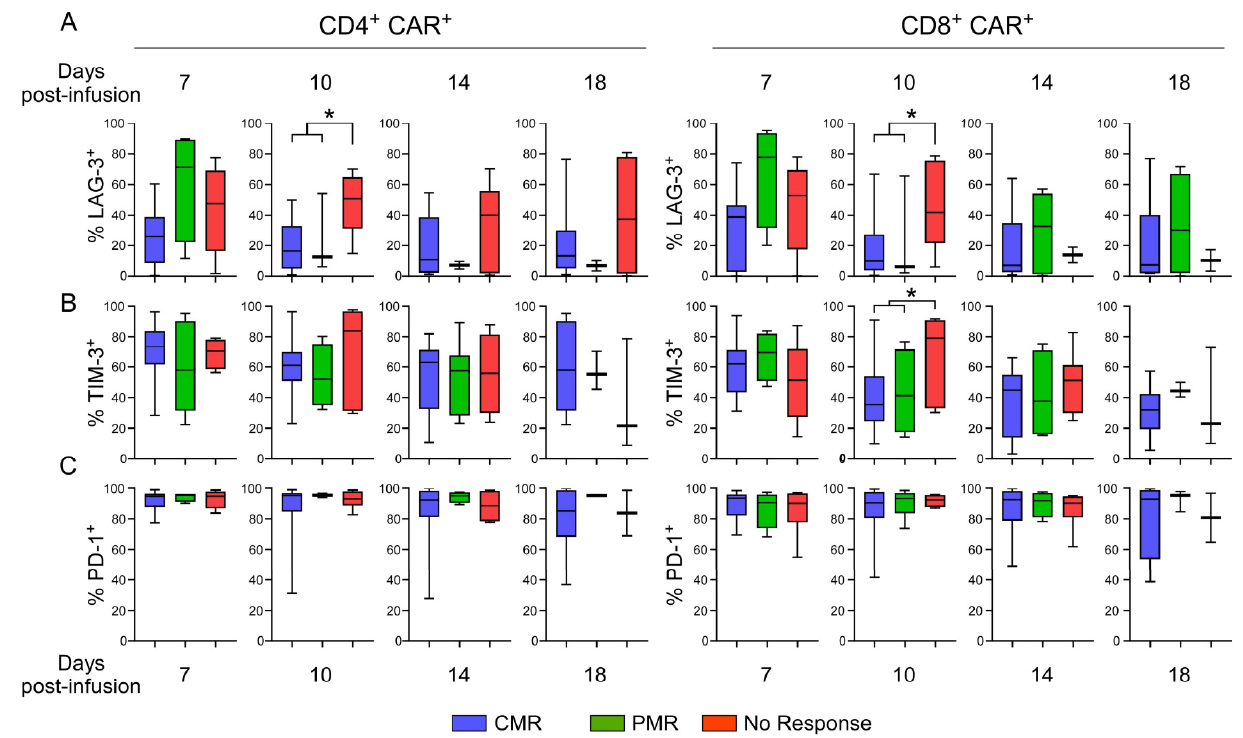
Figure 5. Evaluation of the exhaustion phenotype of CAR + T-cells following infusion. Exhaustion of CD4 + CAR + (left) and CD8 + CAR + (right) T-cells was evaluated from days 7 to 18 following CAR T infusion as a function of LAG3 ( A ) TIM-3 ( B ) and PD-1 ( C ) expression. Expression was assessed in patients with a CMR (n:13), PMR (n:4), and no response (n:6), and their median, IQR, and range (n:27) are presented. p -values were calculated using a Mann–Whitney test and significant values are shown (*: p < 0.05).